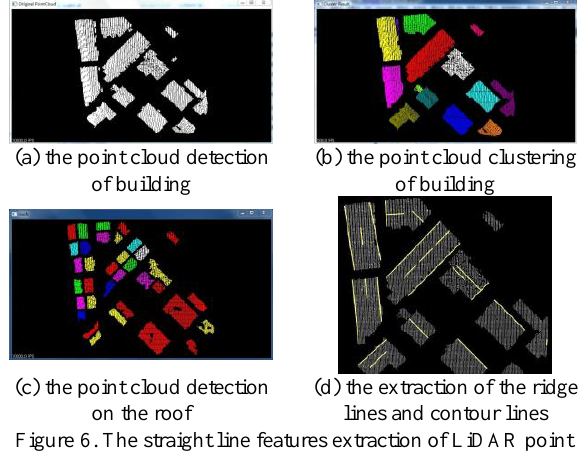
Figure 6. The straight line features extraction of LiDAR point cloud in Vaihingen